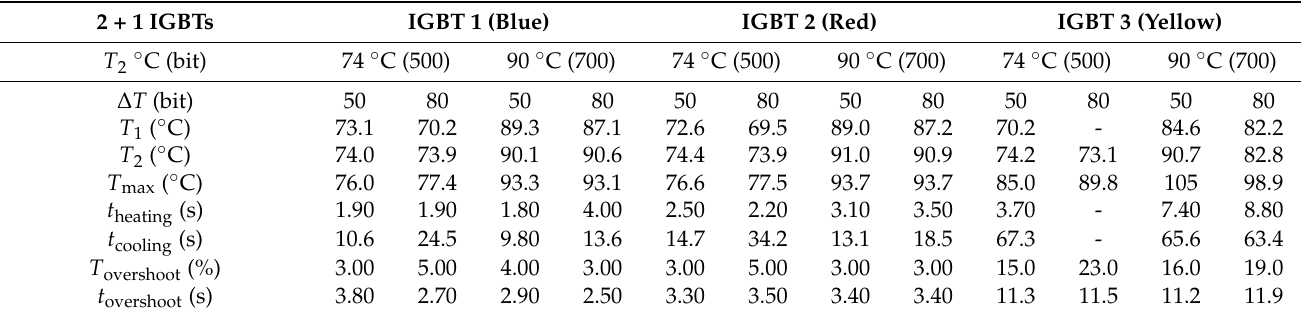
Table 6. Measurement results of NNr algorithm for two main and one redundant